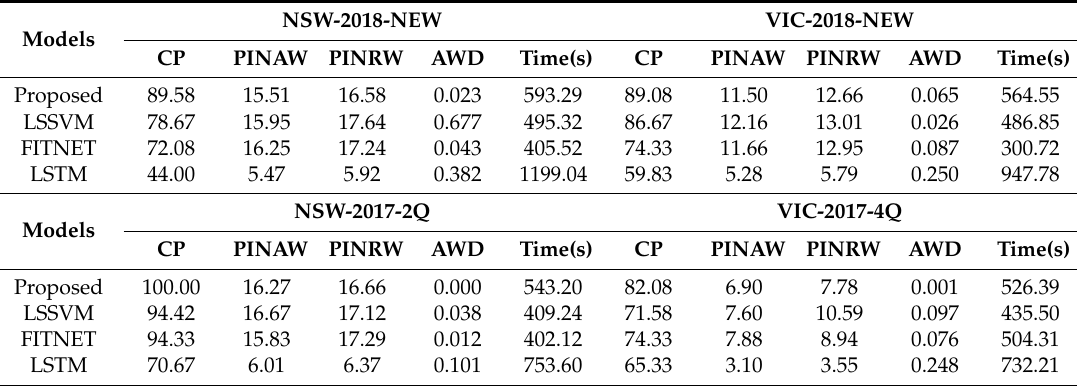
Table 7. Consistency analysis results of some basic models and new